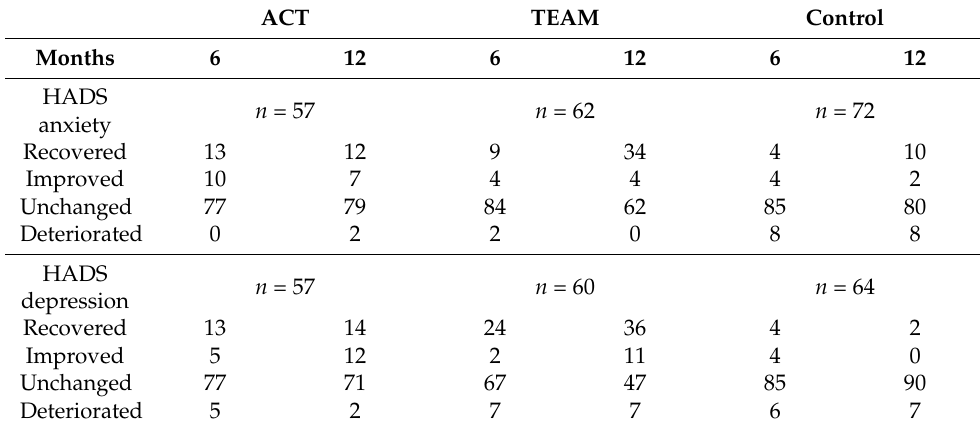
Figure 2. Mean outcomes on imputed data of ( A ) pain, ( B ) anxiety, ( C ) depression, ( D ) satisfaction with life and ( E ) general well-being at 0, 6, and 12 months for ACT, TEAM and Control with 95% confidence intervals. Note: ACT—acceptance and commitment therapy; TEAM—multidisciplinary assessment and treatment programme; HADS—hospital anxiety and depression scale; SWLS—satisfaction with life scale; GHQ—general health questionnaire. Table 5. Clinically significant change for anxiety and depression at 6 months and 12 months presented in percent in each